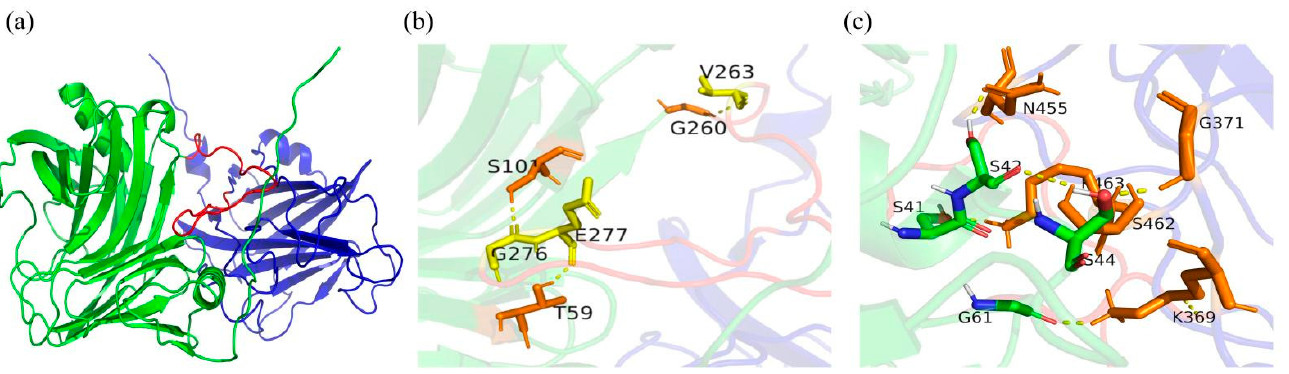
Figure 3. Three-position structure diagram and novel hydrogen bonding interaction of the best chimera CDBFV-C2. The highest-scoring chimera protein structure model was visualized with PyMOL software for visual display, structure super- position, difference analysis, and coloring. Red represents the linker; blue represents the C2; green represents the CDBFV. ( a ) Three-position structure diagram of the best chimera CDBFV-C2. ( b ) Illustration of the newly formed hydrogen bond- ing interaction between CDBFV and linker in the best chimera CDBFV-C2. ( c ) Illustration of the newly formed hydrogen bonding interaction between CDBFV and C2 in the best chimera CDBFV-C2.